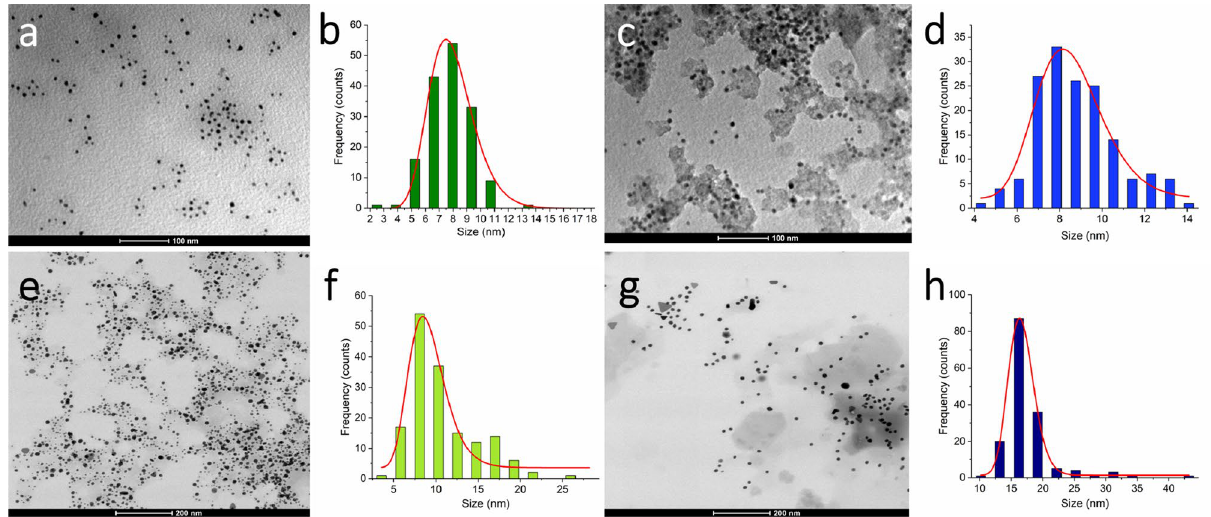
Figure 3. TEM images and size distribution histograms of biosynthesized gold nanoparticles: ( a , b ) AuNP extract ; ( c , d ) AuNP ethyl acetate ; ( e , f ) AuNP dichloromethane ; ( g , h ) AuNP hexane.